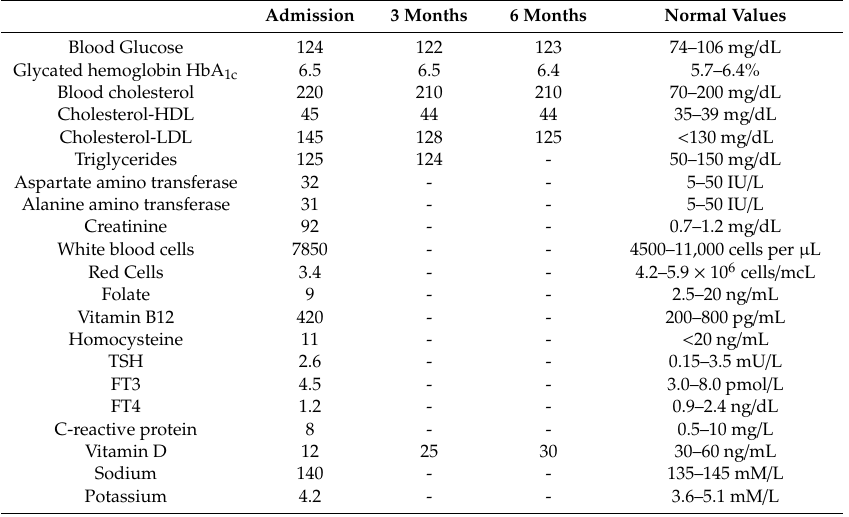
Table 2. Laboratory tests in patient at the time of the enrollment and of follow-ups (3 and 6